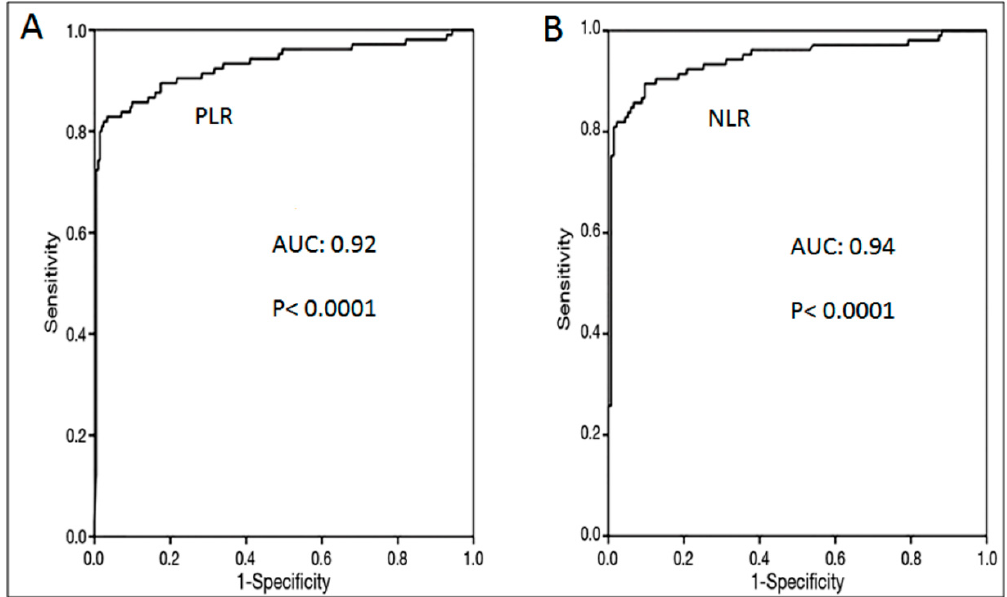
platelet/lymphocyte ratio.